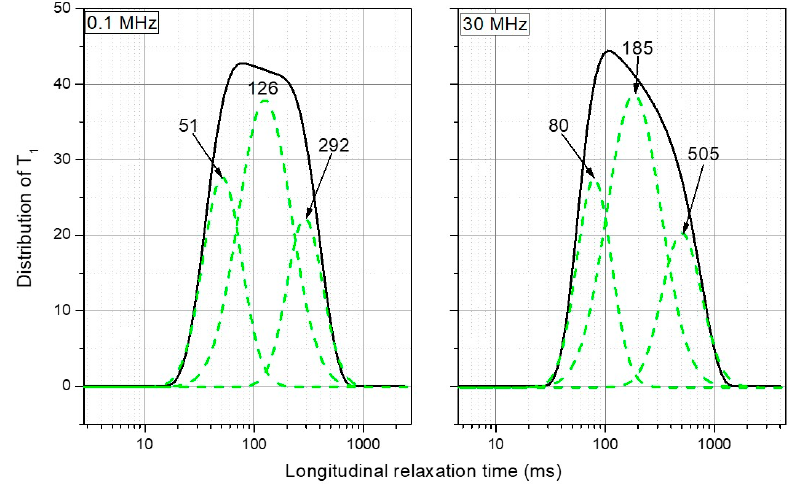
Figure 5. Relaxograms obtained by the uniform penalty regularization (UPEN) algorithm applied on the decay and recovery curves reported in Figure 3. The dashed green lines represent the deconvolution curves of the two relaxograms (unpublished results).